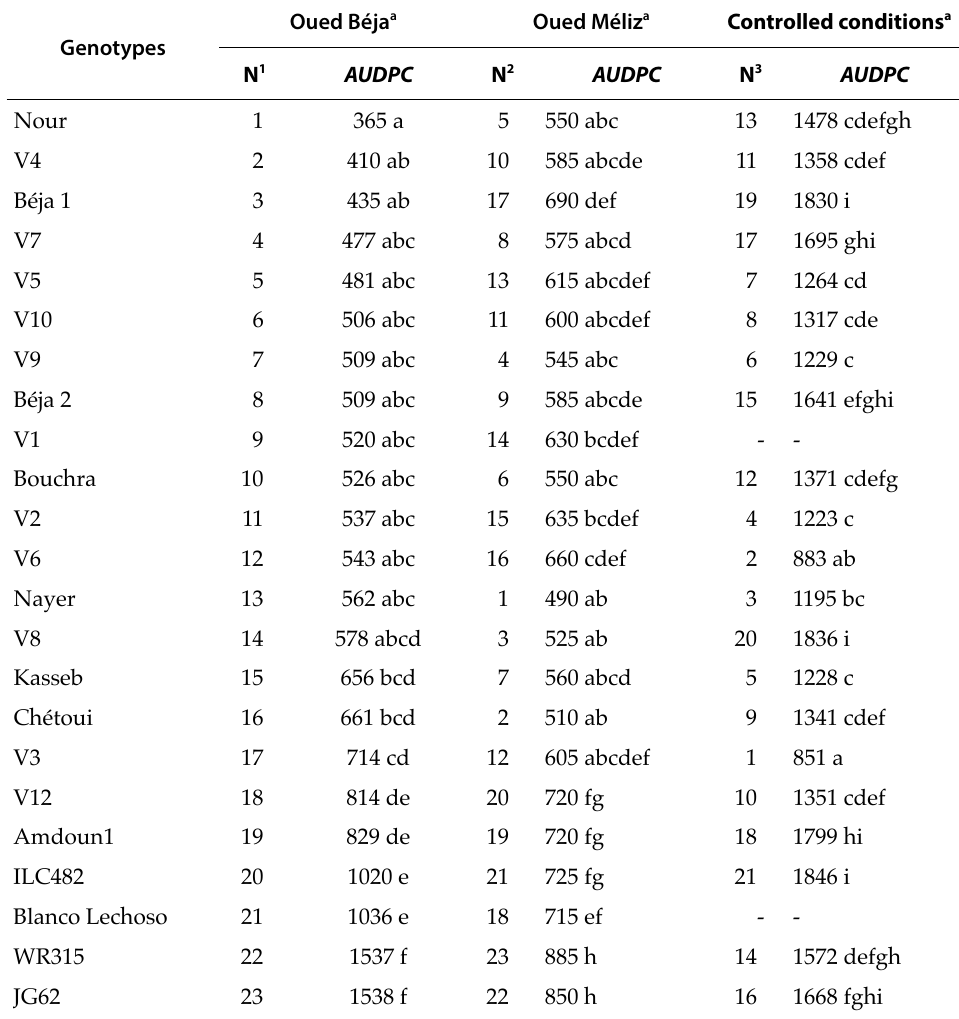
Table 3. Area Under the Disease Progress Curve (AUDPC) mean values and classification of the 23 genotypes studied at two field locations and under controlled